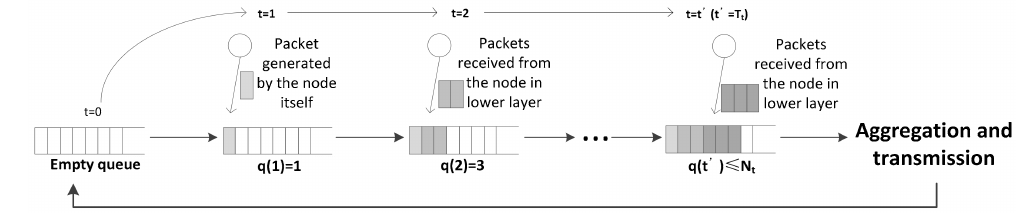
Figure 4. Packet aggregation occurs since the value of the aggregation timer is equal to T t